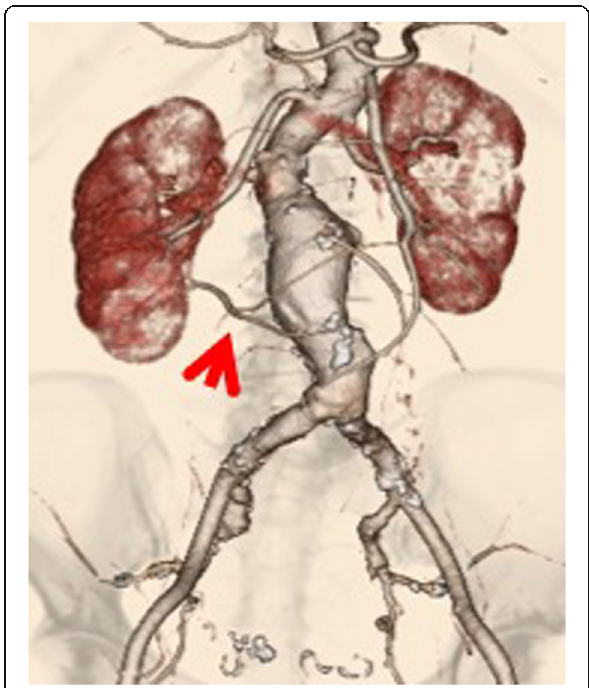
Fig. 1 Preoperative enhanced CT. The maximum diameter of the AAA was 53 × 57 mm, and the diameter of the right ARA was 4 mm ( arrow )